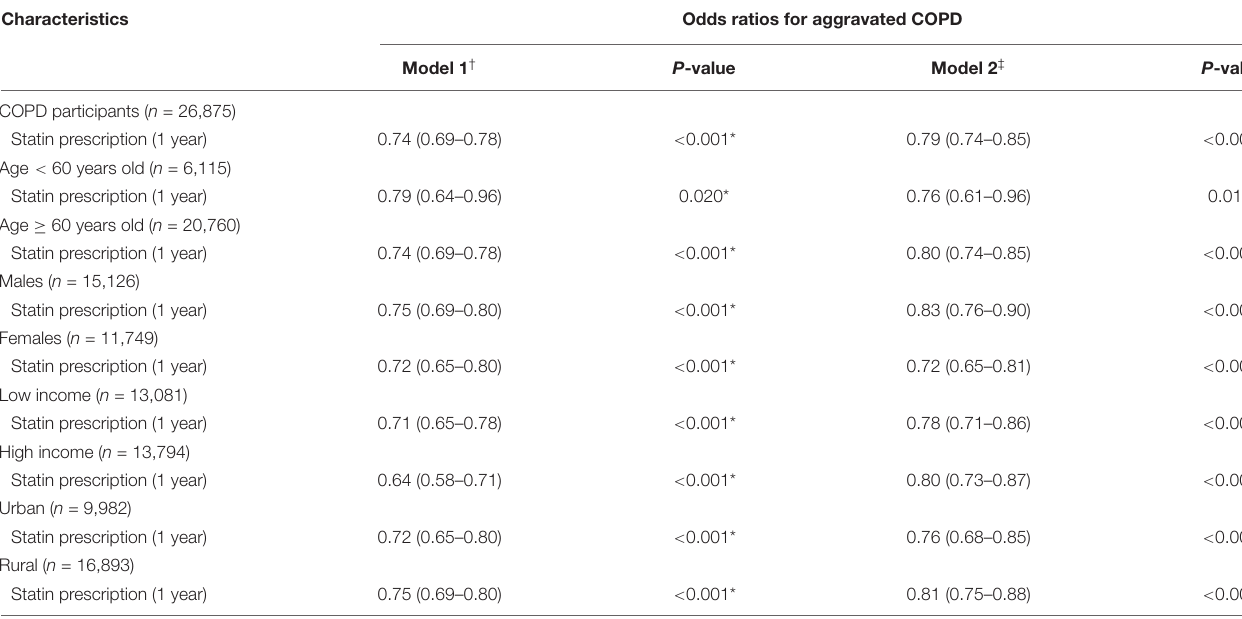
TABLE 2 | Odds ratios (95% confidence intervals) of the dates of statin prescription (1 year) for the occurrence of COPD. Characteristics